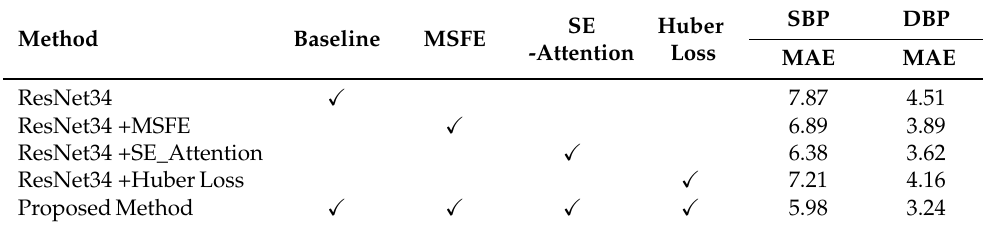
Table 1. Results of the ablation experiment